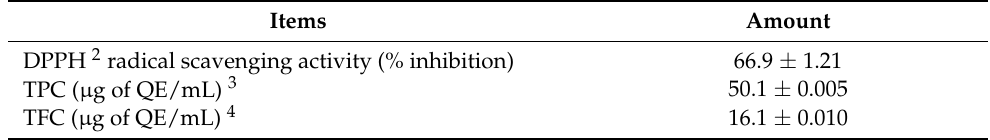
Table 3. Antioxidant activity, total polyphenols, and total flavonoids in fermented pine needle extract 1 .